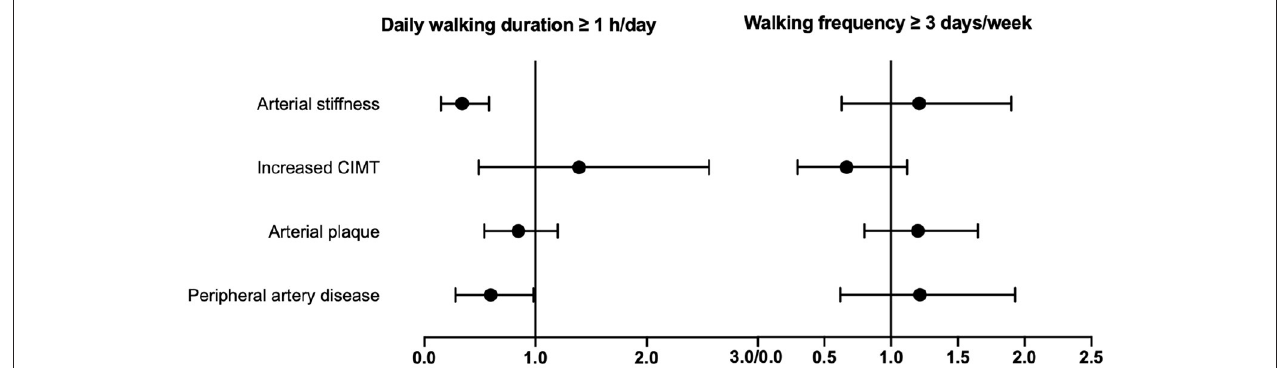
FIGURE 2 | Subgroup analysis of the association of daily walking duration or walking frequency with vascular HMOD. Multivariate logistic regressions were performed to investigate the association of walking duration ≥ 1 h/day or walking frequency ≥ 3 days/week with vascular HMOD. Adjusted ORs and 95% CI are presented after adjustment for walking frequency or walking duration, together with cardiovascular risk factors (including age, gender, smokers, body mass index, systolic blood pressure) and concomitant diseases (hypertension, diabetes mellitus, coronary heart disease), respectively. CIMT, carotid intima–media thickness; HMOD, hypertensive mediated organ damage; OR, odds